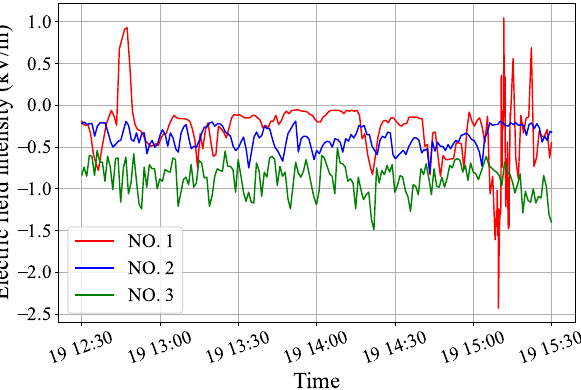
Figure 1. Atmospheric electric field meter and its distribution. ( a ) Schematic diagram of atmospheric electric field meter; ( b ) Physical view of atmospheric electric field meter; ( c ) Geographical distribution of electric field stations.